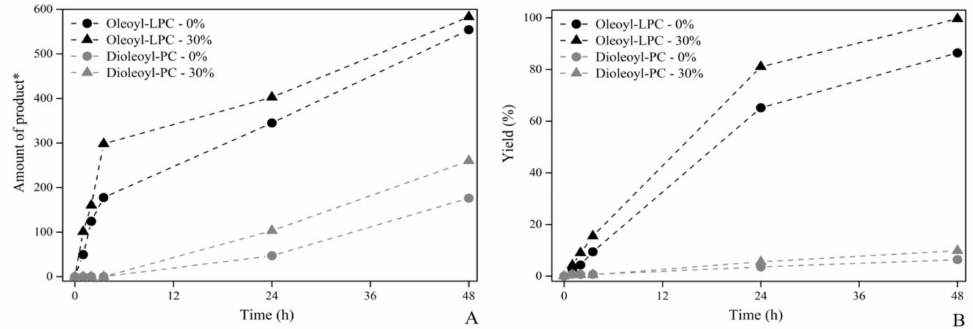
Figure 3. Kinetic profiles for the Glycerophosphocholine (GPC) esterification with oleic acid catalyzed by Eversa ® Transform 2.0 lipase immobilized on Immobead IB-ADS-3 (ADS3) by ( A ) Thin-Layer Chromatography (TLC) and ( B ) High-Performance Liquid Chromatography (HPLC). Dotted lines are presented to improve visualization. Arbitrary